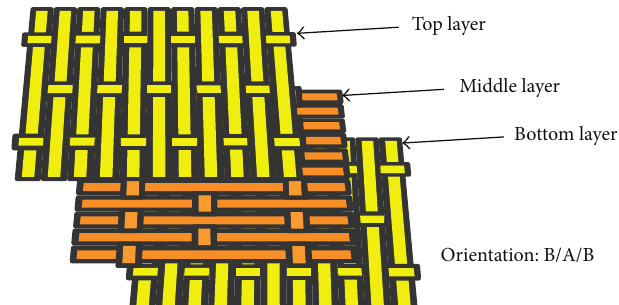
Figure 5: Sample 2: orientation B/A/B.